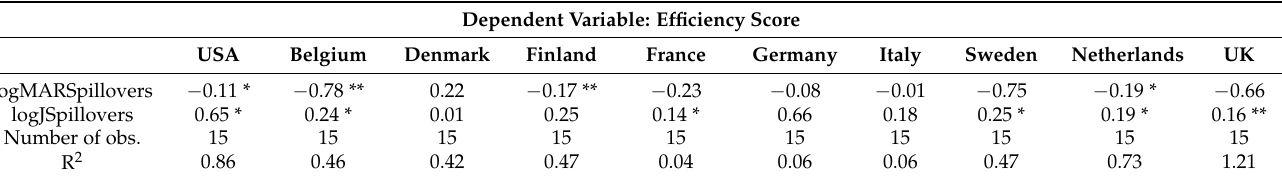
Table 8. OLS regression by